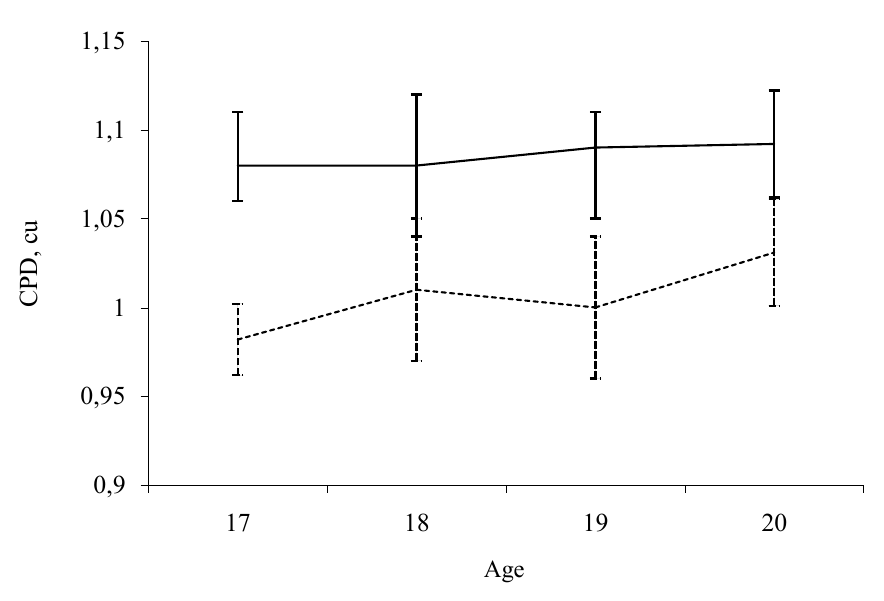
Fig.2. Age Dynamics of Physical Development among boys and girls aged 17-20; * - reliable differences of CPD values between boys and girls (р<0.05); *** - reliable differences of CPD values between boys and girls